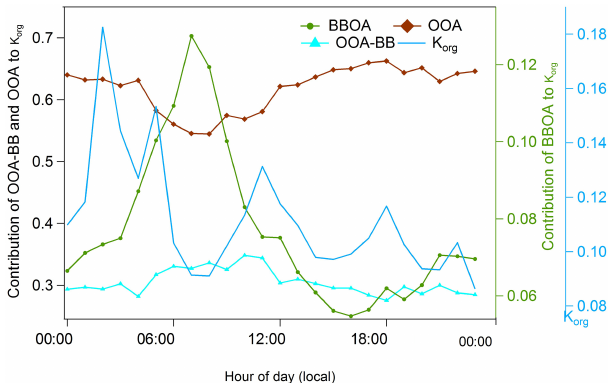
Figure 8. Average diurnal contribution of each organic aerosol fac- tor to the κ org computed by multiplying the mass fraction by the corresponding inferred hygroscopicity parameter and the predicted diurnal profile of the total κ org in the ambient